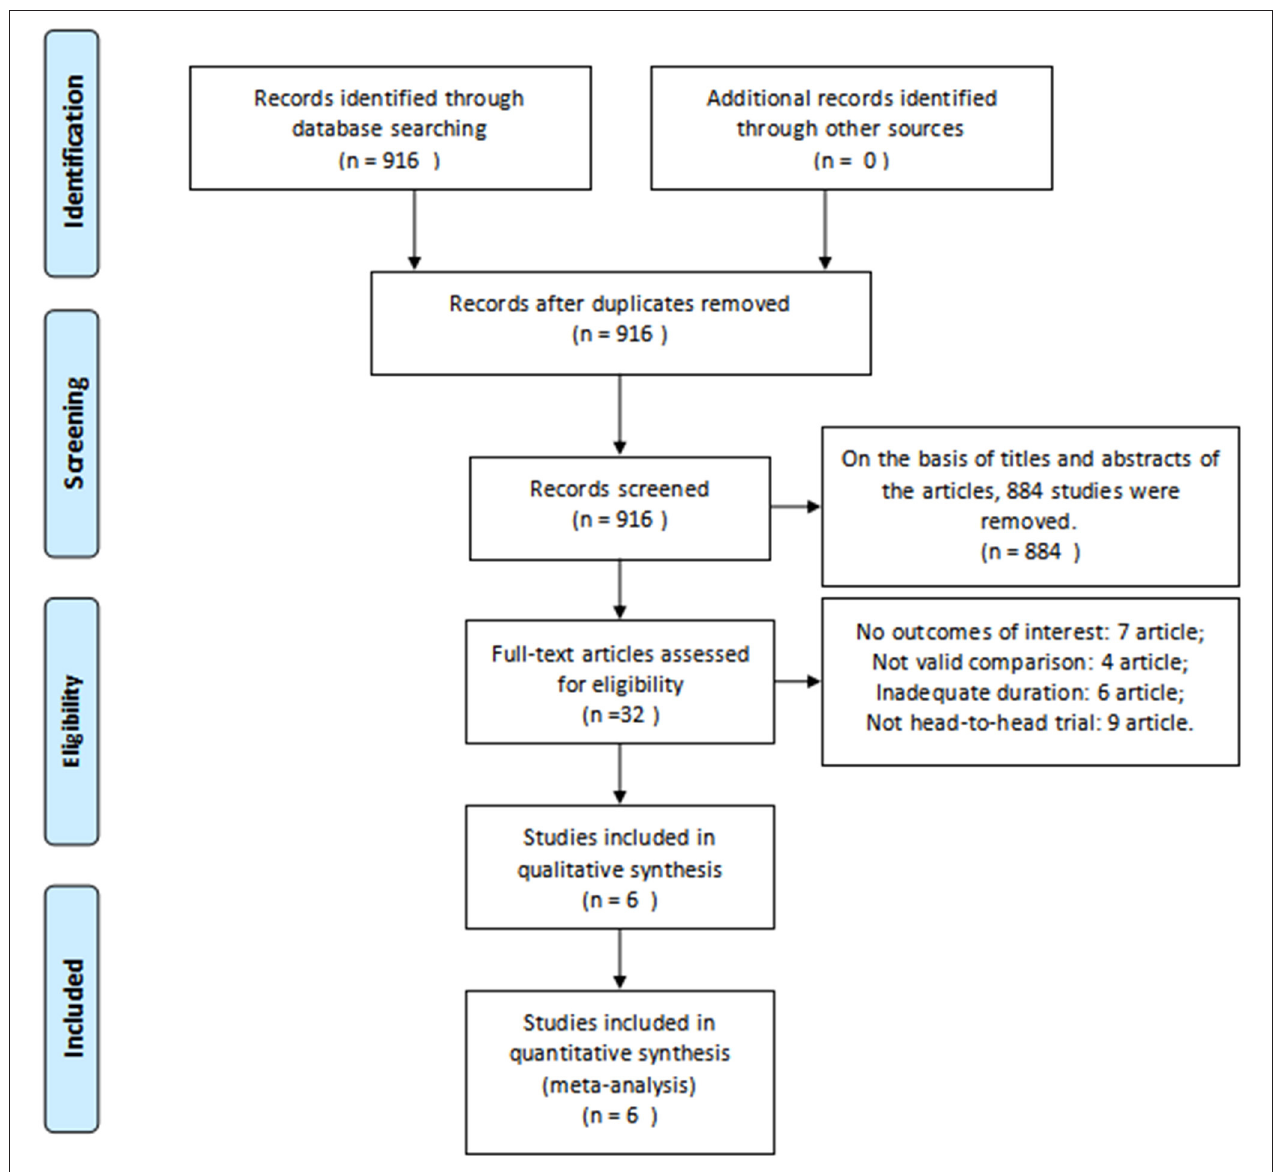
FIGURE 2 | Flowchart of the study selection process. RCT, randomized controlled